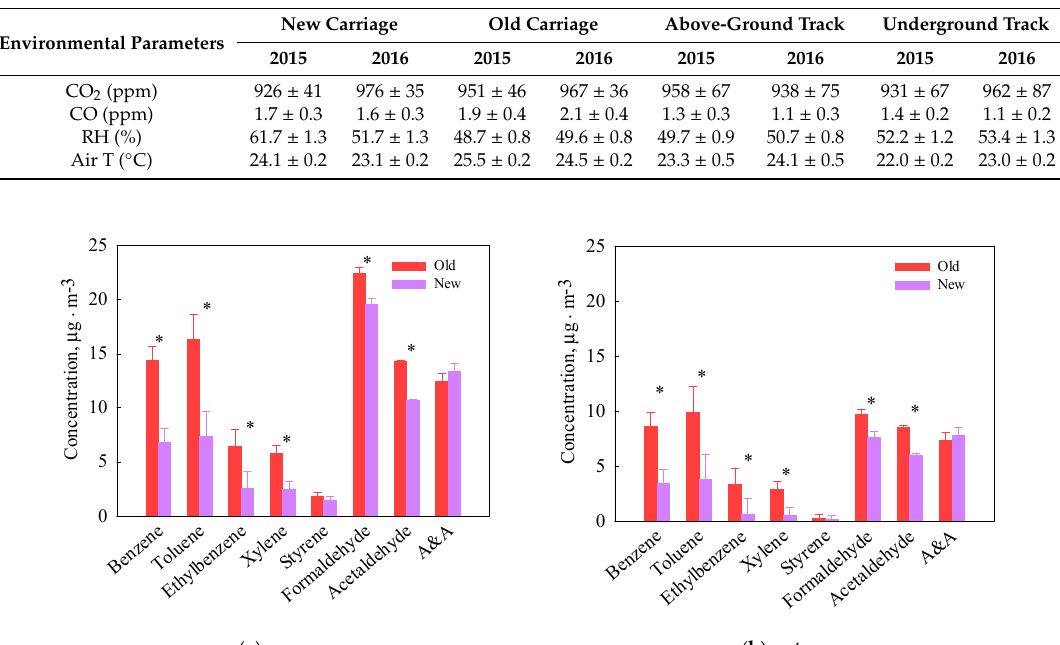
Figure 1. 2015–2016 averaged VOC concentrations in metro carriages of Line 1 (Old) and Line 10 (New) during ( a ) summer and ( b ) autumn. The error bar indicates the standard deviation for four replicates. “*” indicates the difference between the average VOCs value in the new and old metro carriage (P < 0.05). A&A: Acetone and Acrolein. 2015 data is from Ref. [35].